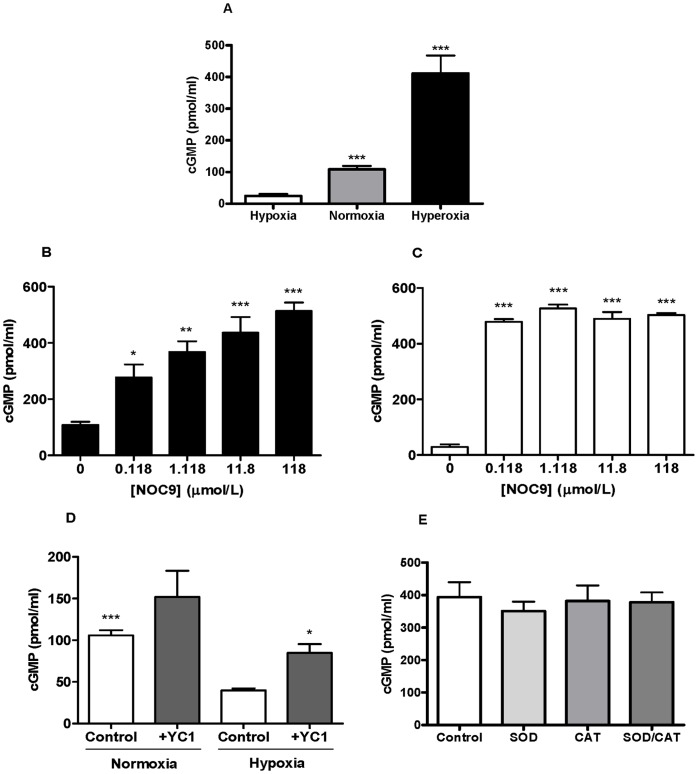
Measurement of cGMP as an index of sGC activity in normoxic and hypoxic conditions.a. Comparing cGMP production in hypoxia (0% O2), normoxia (∼21% O2) and hyperoxia (95% O2). Normoxia and hyperoxia stimulated an increased production of cGMP compared with hypoxia. (***p<0.001 cf. hypoxia, n = 4–6). b. Concentration response curve to NOC9 under normoxic conditions. Significant differences were observed at each concentration level compared to the control containing no NOC9, ***p<0.001 cf. 0 µmol/L, **p<0.01 cf. 0 µmol/L and *p<0.05 cf. 0 µmol/L (n = 3 to 6 experiments). c. Concentration response curve to NOC9 under hypoxic conditions. Significant differences were observed at each concentration level compared to the control containing no NOC9, ***p<0.001 cf. 0 µmol/L (n = 3 to 6 experiments). cGMP detected for 0.118 and 1.118 µmol/L NOC9 were much greater than the levels in normoxia initiated by the same concentrations. d. Exposure of sGC to the NO-independent activator YC-1 (100 µmol/L). Paired analysis of cGMP levels catalysed by sGC revealed a significant increase in the normoxic control versus hypoxic control, ***p<0.001 cf. hypoxia control. The addition of YC-1 in normoxia induced an increase in cGMP compared to control but this was not significant. A similar trend was observed in hypoxia, however the addition of YC-1 induced a significant rise in cGMP, *p<0.05 cf. control. (n = 4). e. SOD (100 U/ml) and CAT (250 U/ml) incubated with sGC in normoxia stimulated a similar level of cGMP compared to the control, p>0.05 cf. control. (n = 4).